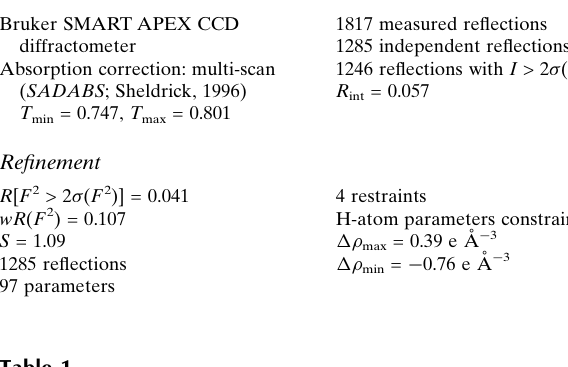
Hydrogen-bond geometry (A˚ , (cid:2)